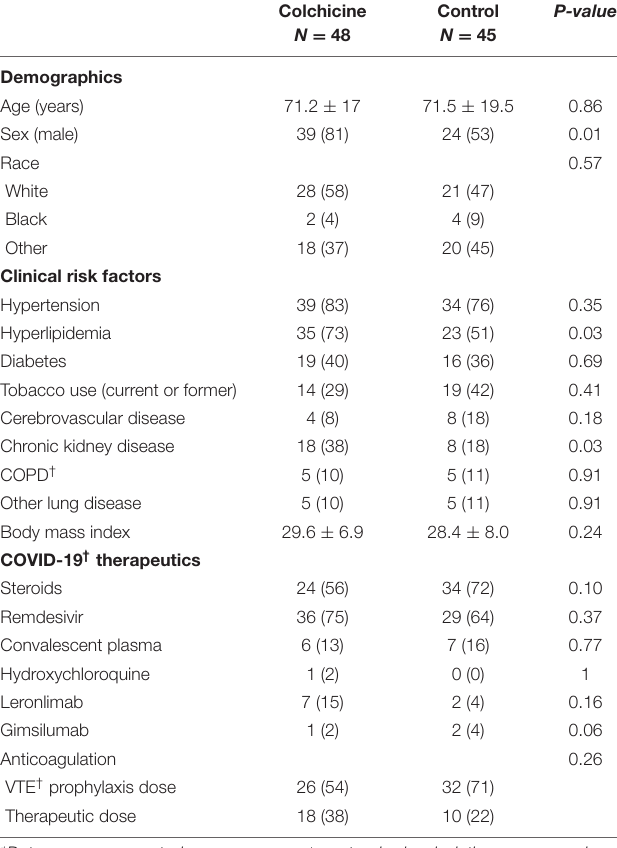
TABLE 1 | Baseline patient